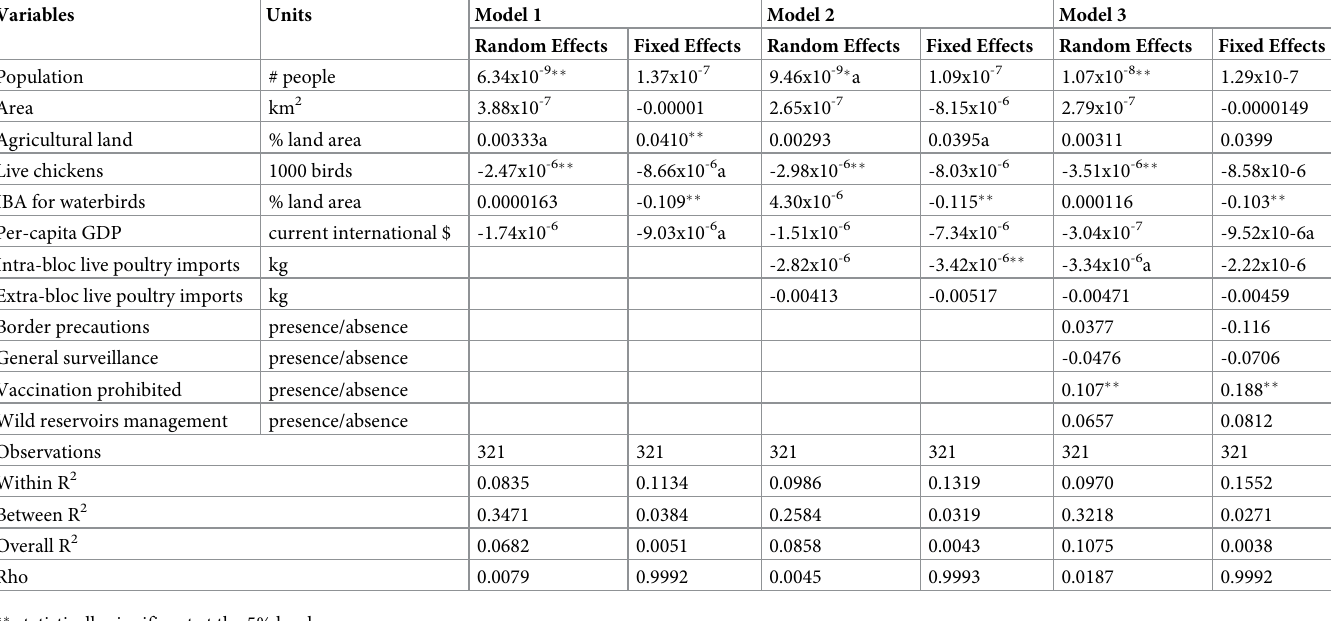
Table 5. Results from the regression models of H5N1 poultry outbreak risk factors for the European Union (EU); regressor coefficients are reported and statisti- cally-significant factors are marked by asterisks. A blank space signifies that the variable was not included in the given